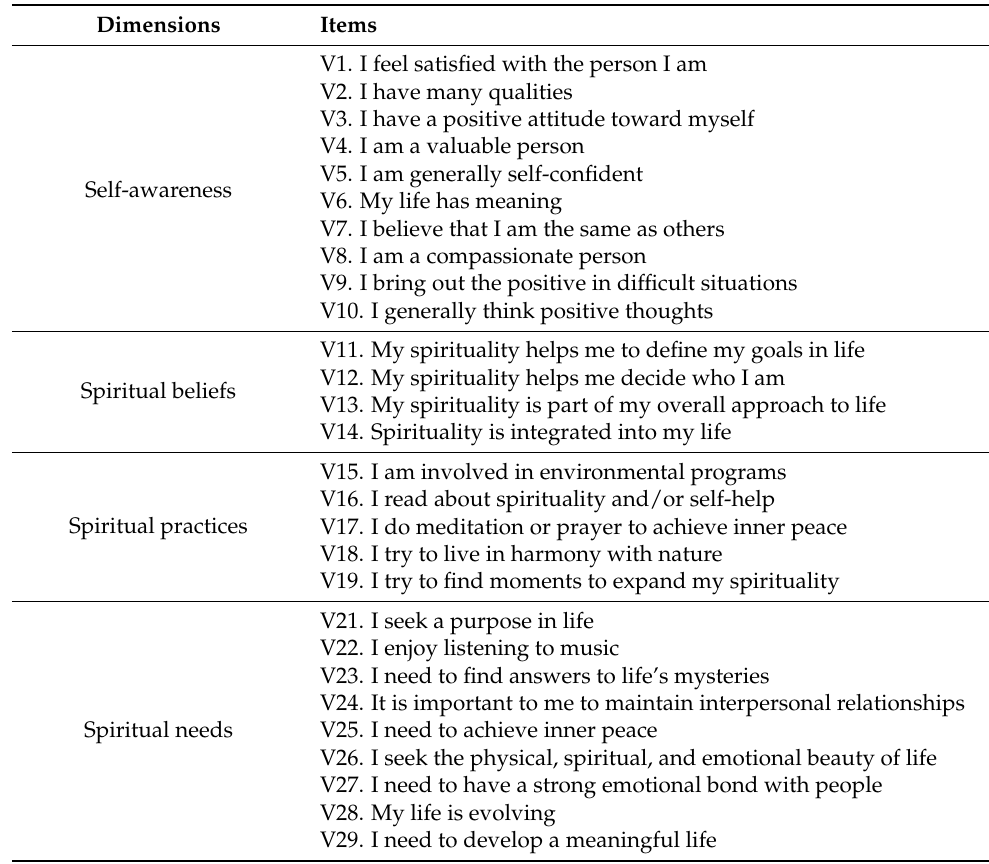
Table 2. Spirituality questionnaire.